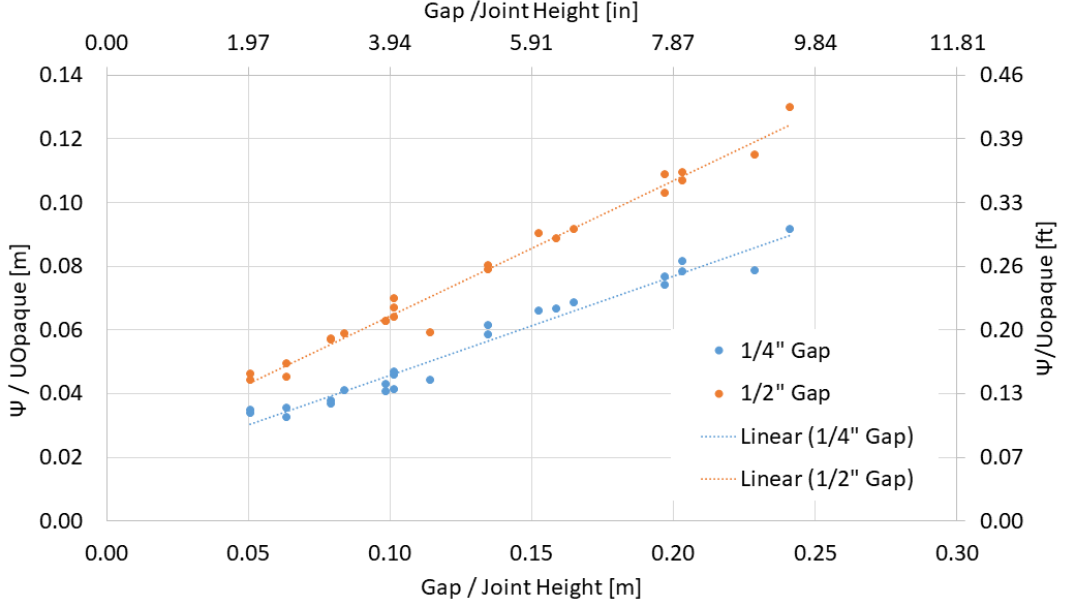
Figure 11. Psi Factor Divided by Thermal Transmittance as a Function of the Height of the Joint.